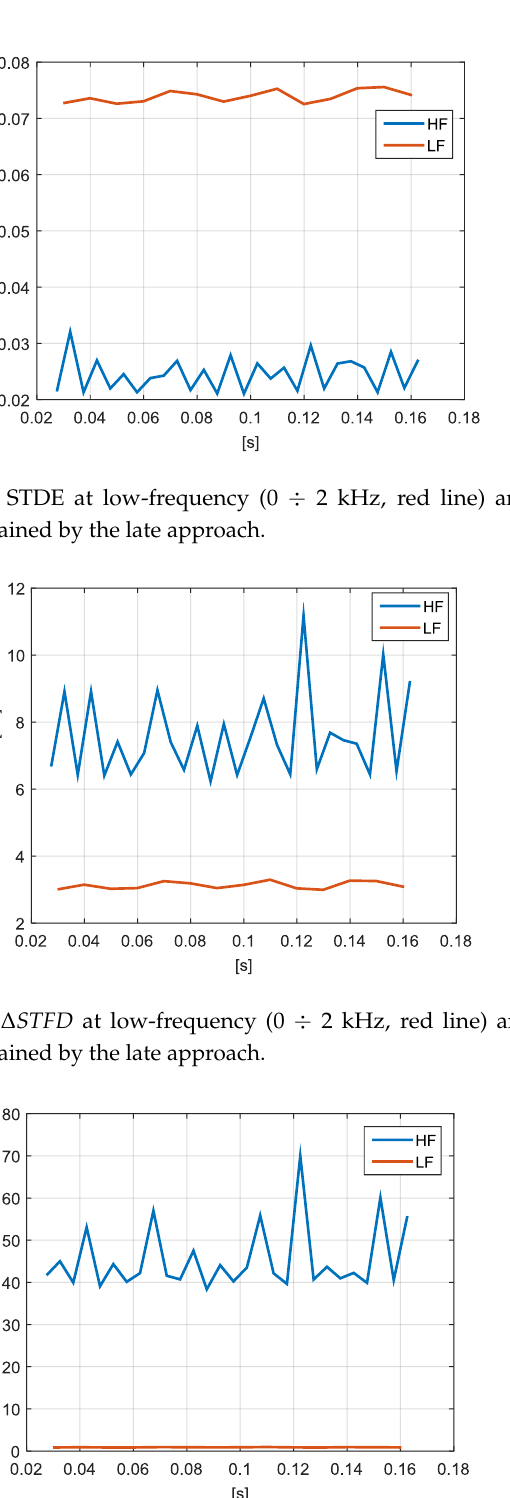
Figure 14. Case study 2: Δ STK at low-frequency (0 ÷ 2 kHz, red line) and at high-frequency (2 ÷ 150 kHz, blue line) obtained by the instantaneous approach.